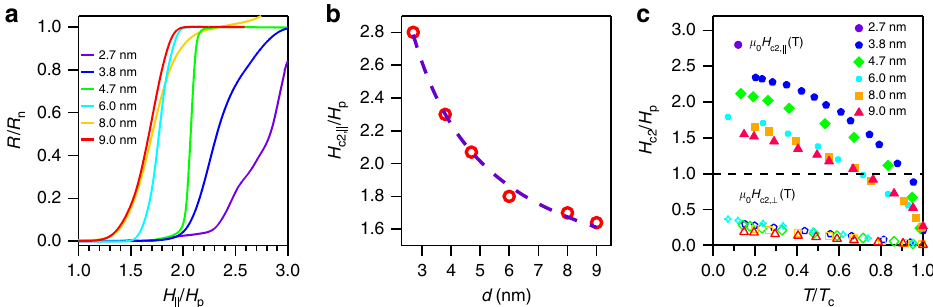
Fig. 3 Enhanced in-plane upper critical fi eld in few-layer 1 T d -MoTe 2 . a Magnetic fi eld dependence of the resistance for 1 T d -MoTe 2 devices with various thicknesses from 2.7 to 9 nm. The resistances and magnetic fi elds are normalized by the normal state resistance R n and the Pauli limit H p , respectively. b = H Normalized in-plane upper critical fi eld H as a function of sample thickness d . The purple dashed line is a guide to the eye. c Normalized upper c 2 ; k p = H critical fi eld H as a function of reduced T / T c for few-layer MoTe 2 . The black dashed line denotes the Pauli limit H p c 2 p